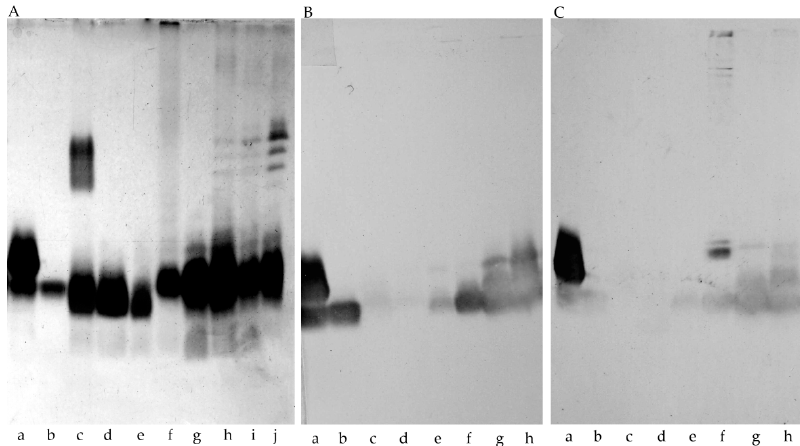
Figure 1. Electrophoretic profiles ( A ) of the LPS from (a) B. pertussis 186, (b) Bordetella pertussis 606,